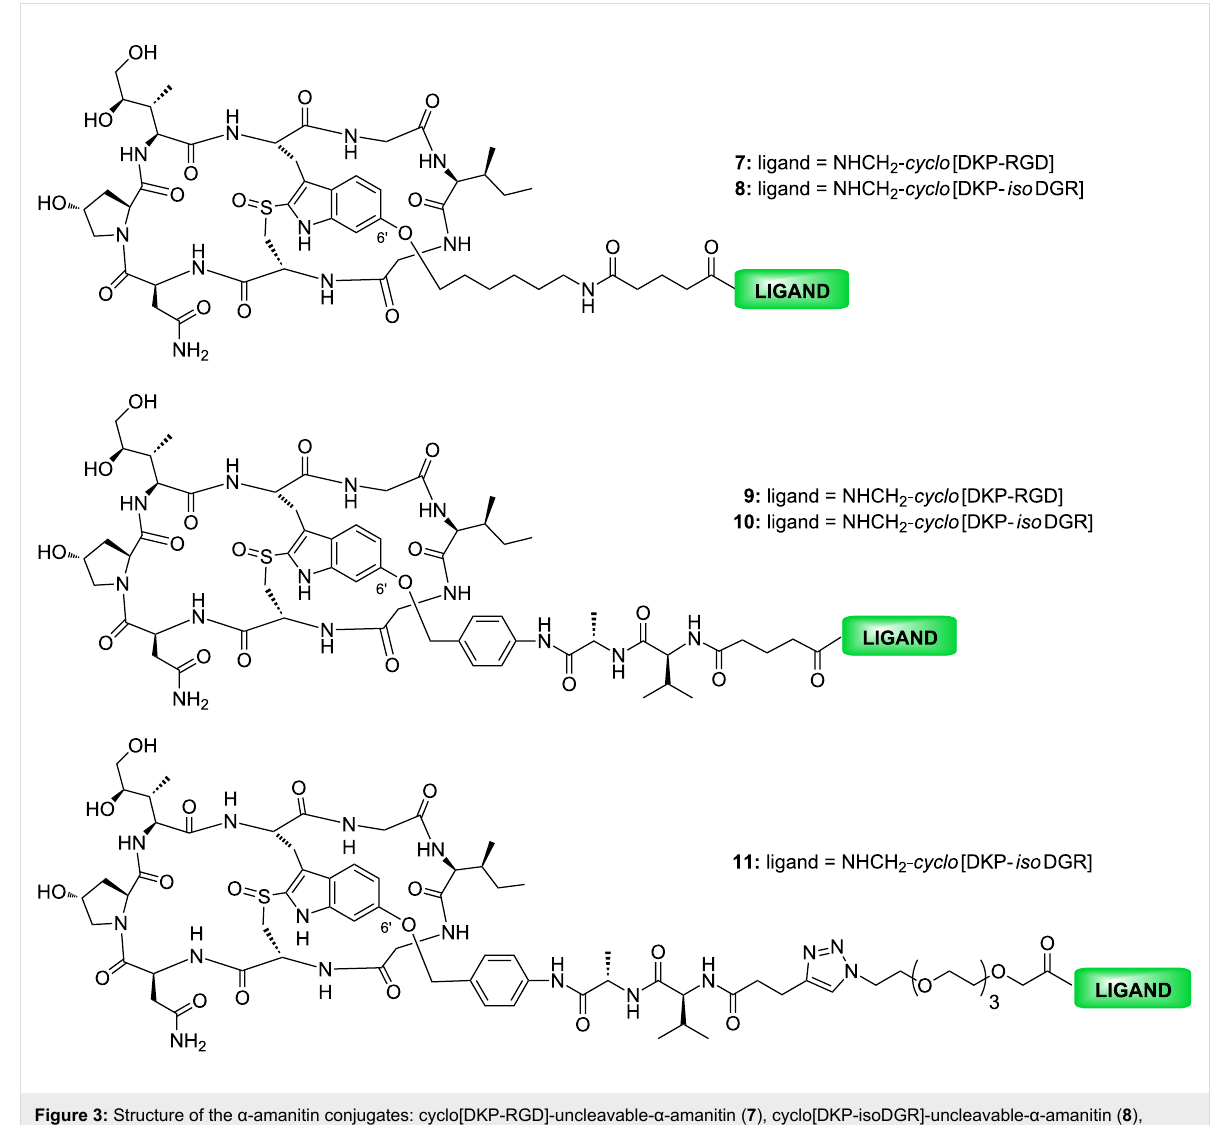
Figure 3: Structure of the α -amanitin conjugates: cyclo[DKP-RGD]-uncleavable- α -amanitin ( 7 ), cyclo[DKP-isoDGR]-uncleavable- α -amanitin ( 8 ), cyclo[DKP-RGD]-Val-Ala- α -amanitin ( 9 ), cyclo[DKP-isoDGR]-Val-Ala- α -amanitin ( 10 ) and cyclo[DKP-isoDGR]-PEG-4-Val-Ala- α -amanitin ( 11 ).